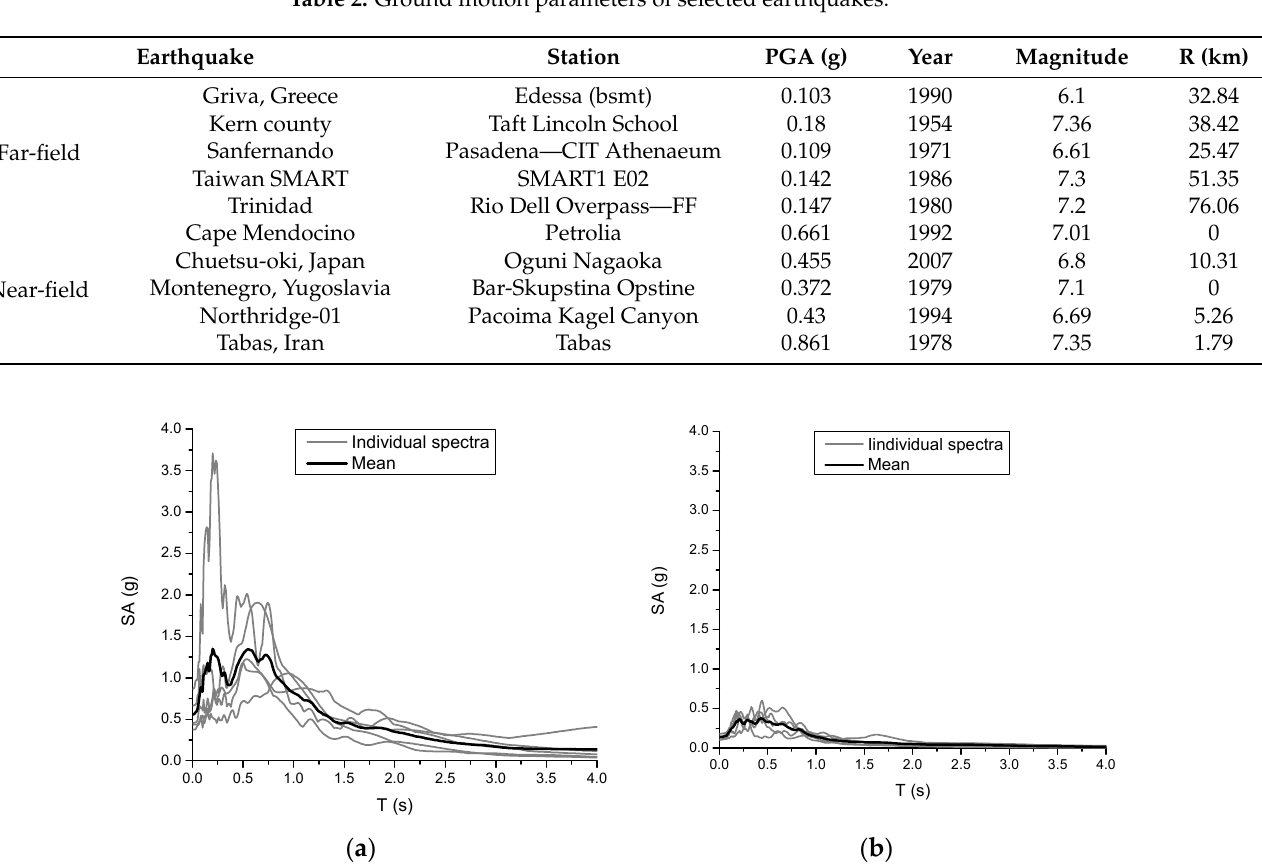
Table 2. Ground motion parameters of selected earthquakes.